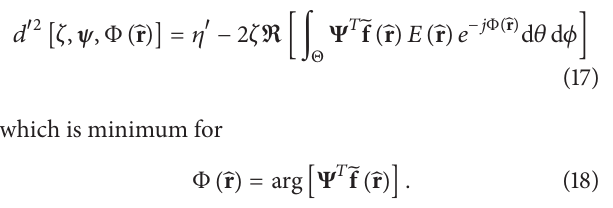
updated by (8b) for 𝑝 = 1, . . . , 𝑁 , the quantities 𝜁 𝑞 , 𝜓 𝑞 , and Φ 𝑞 (̂ r ) are updated by (14), (16) for 𝑝 = 1, . . . , 𝑁 , and (18), respectively. The sequence {𝑑 󸀠2 𝑞 } = {𝑑 󸀠2 [𝜁 𝑞 , 𝜓 𝑞 , Φ 𝑞 (̂ r )]} ,